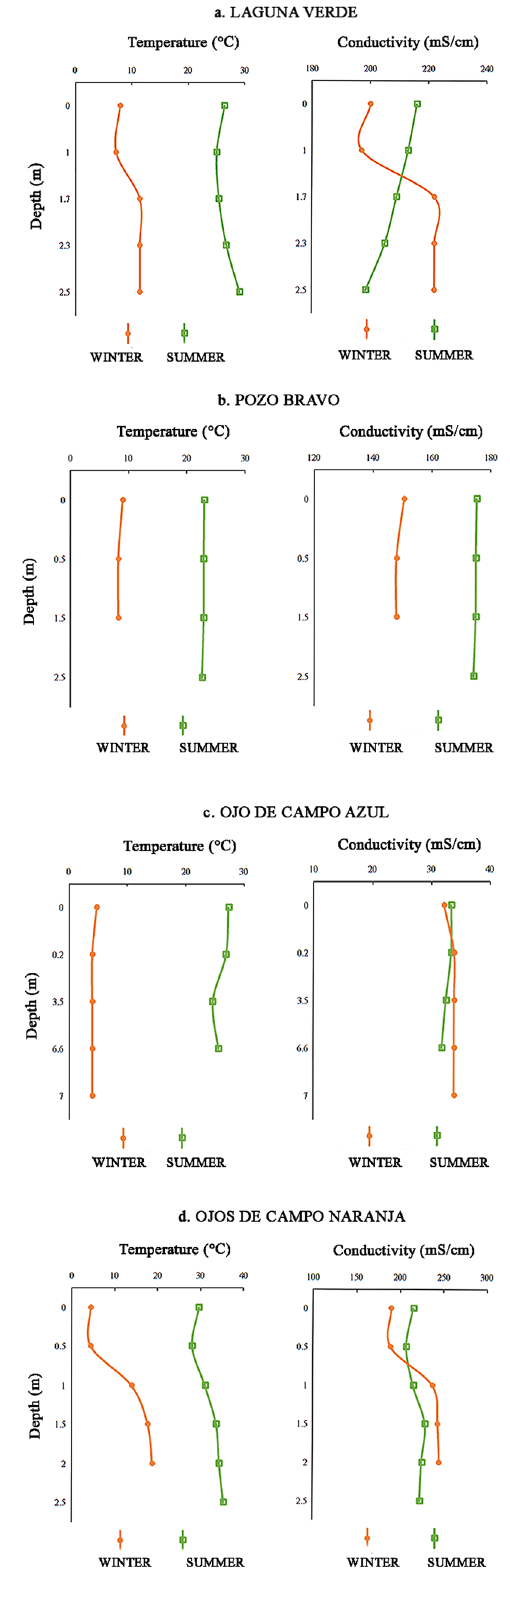
Figure 3. Vertical temperature (°C) and conductivity (mS/cm)